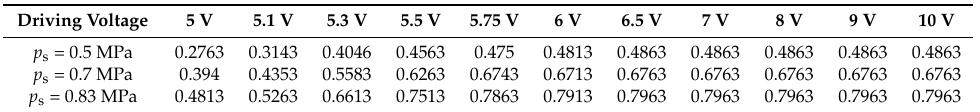
Table 5. Chamber pressure p a of the proportional valve under different driving voltages and supply pressures (MPa). p of the proportional valve under different driving voltages and a supply pressures (MPa).